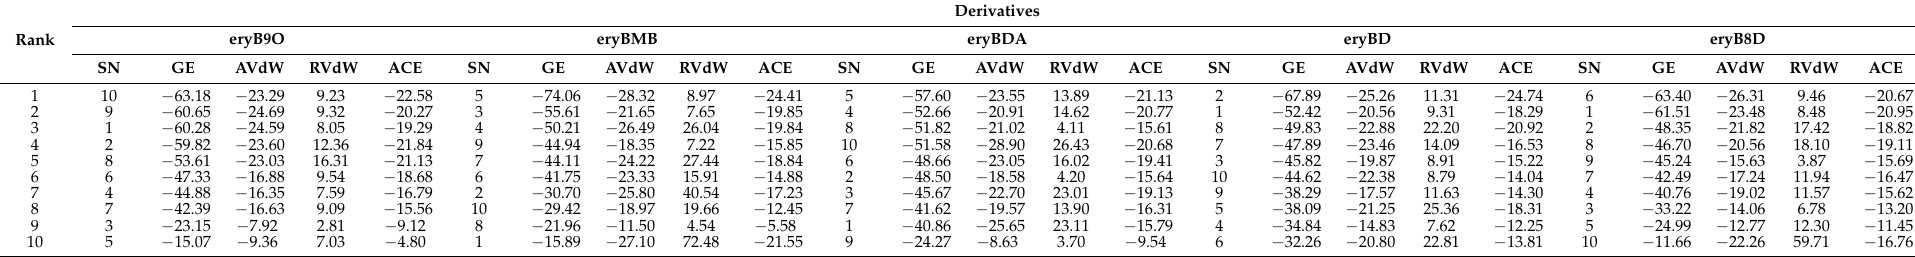
Table 3. Solution number, global energy, attractive Van der Waals, repulsive van der Waals, and ACE for investigated erythromycin B derivatives with in silico constructed segment of the exit tunnel from the apicoplast ribosome of P. falciparum